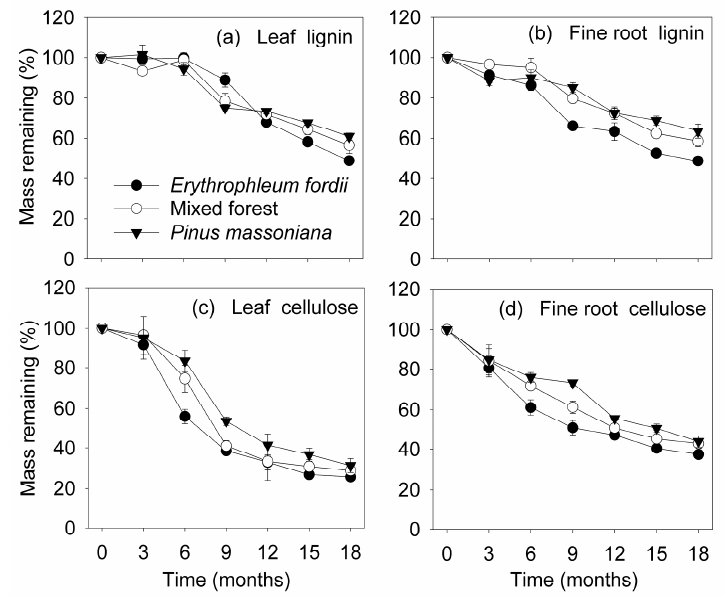
Figure 2. Dynamics of lignin and cellulose remaining mass (mean ± standard error, n = 3) in leaf and fine root litter of three subtropical plantations in China.